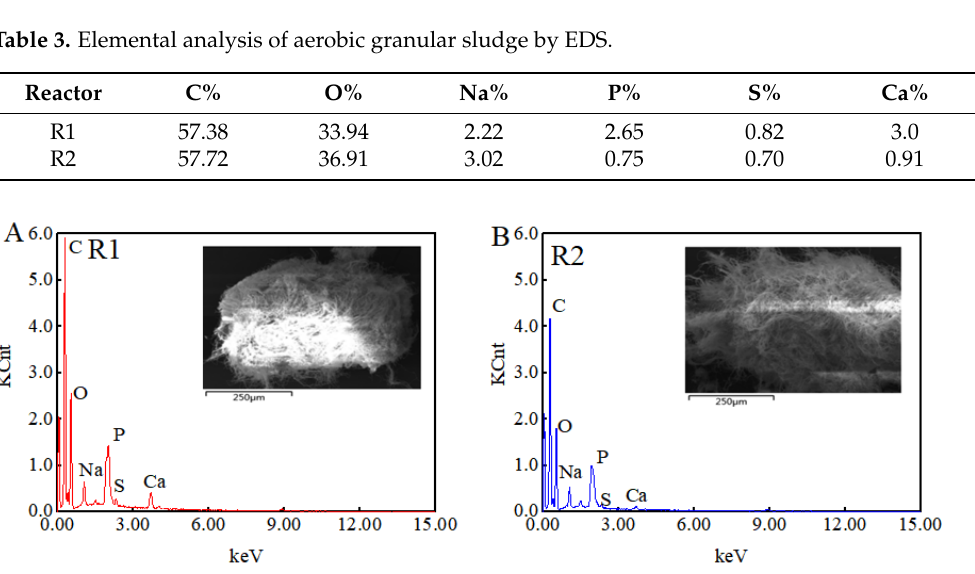
Figure 4. EDS analysis of granules in R1 and R2 on the operation day of 144. ( A ) for R1; ( B ) for